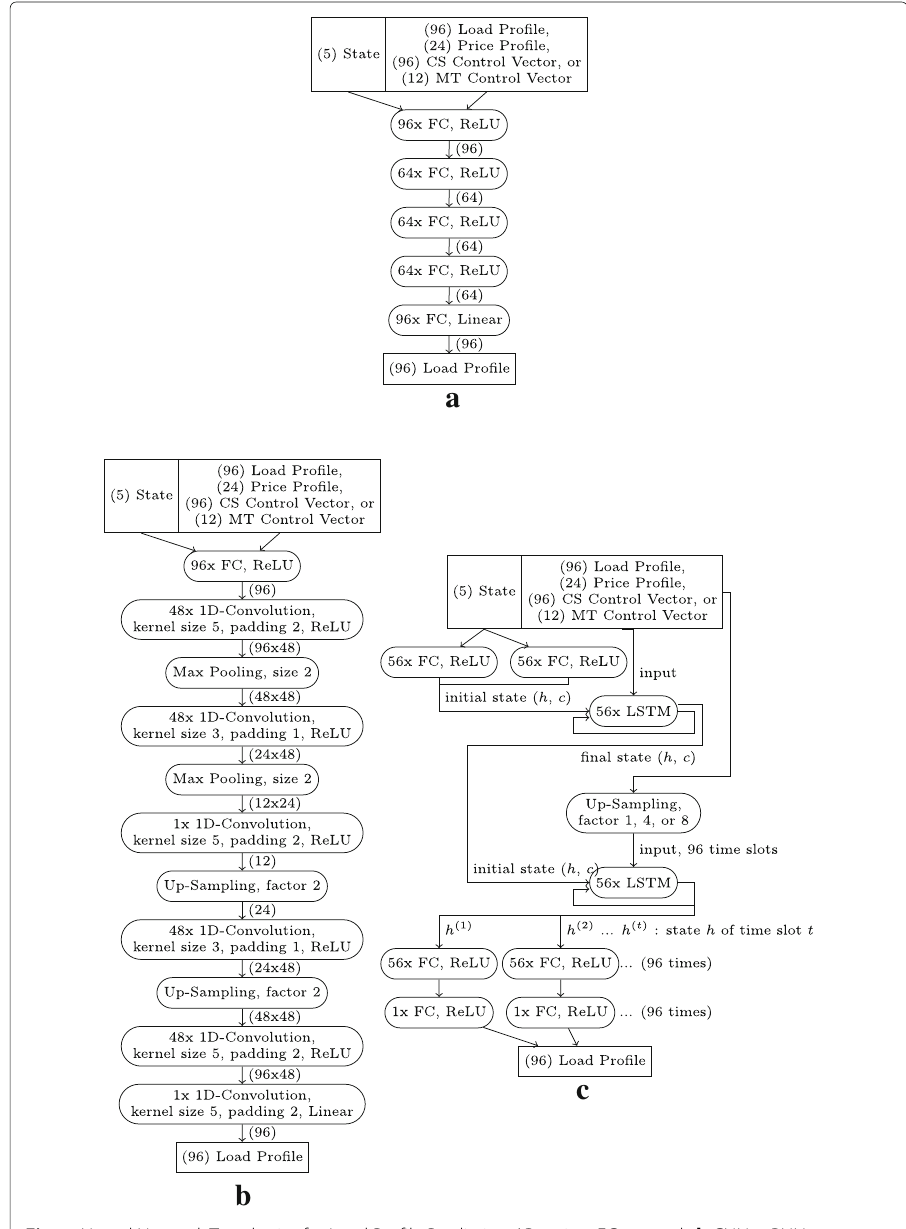
Fig. 4 Neural Network Topologies for Load Profile Prediction / Repair. a FC network, b CNN, c RNN